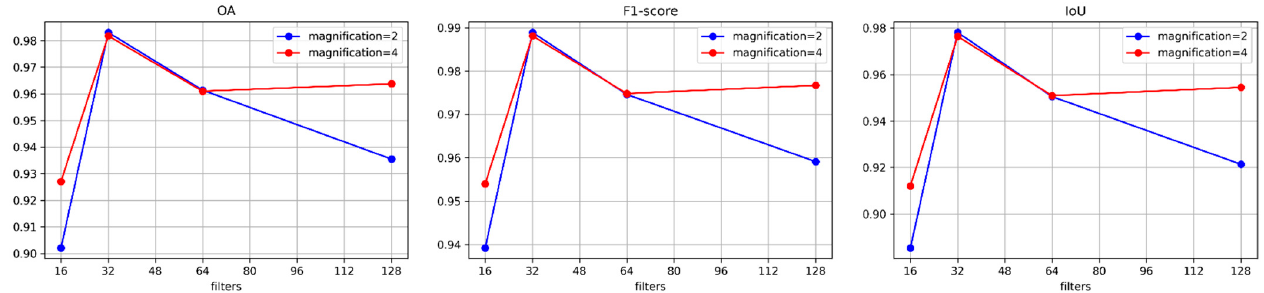
Figure 5. Results of different parameters.